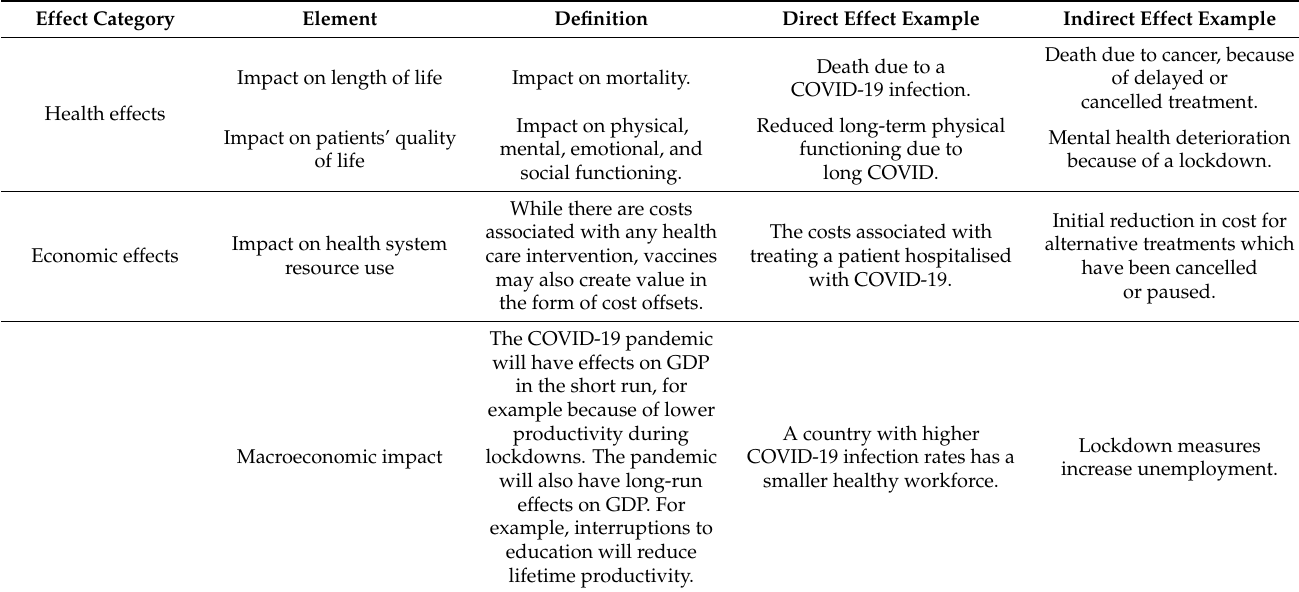
Table A1. Definitions and examples of value